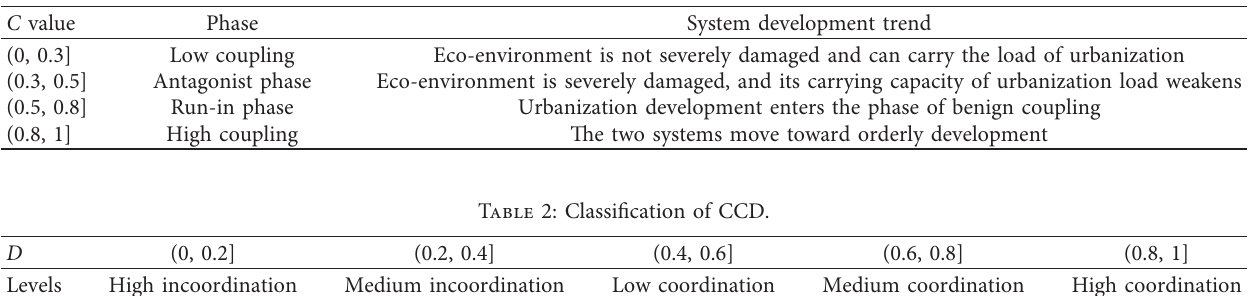
Table 1: Classification of coupling degree.